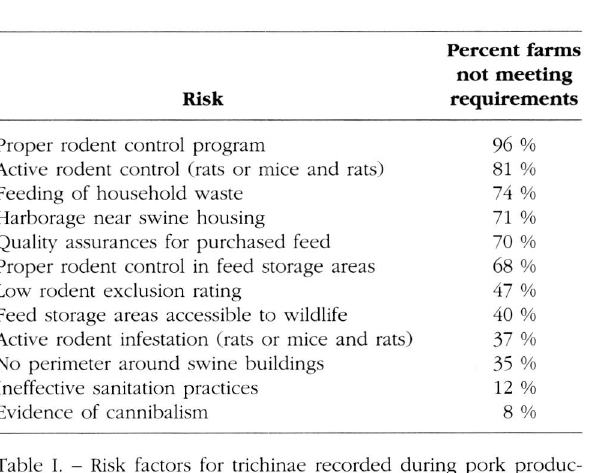
Table I. - Risk factors for trichinae recorded during pork produc tion site audits.